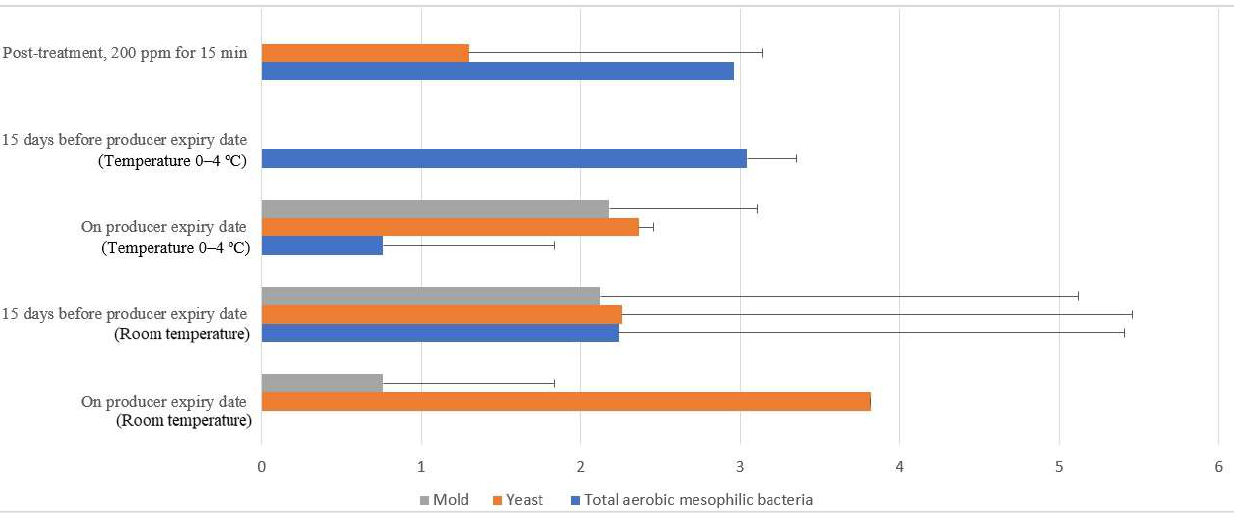
Figure 12. Comparison of the free-range eggshell microbial load (log10 CFU/cm 2 ) during storage at room and chill temperature after washing with 200 ppm quat sanitizer for 15 min.